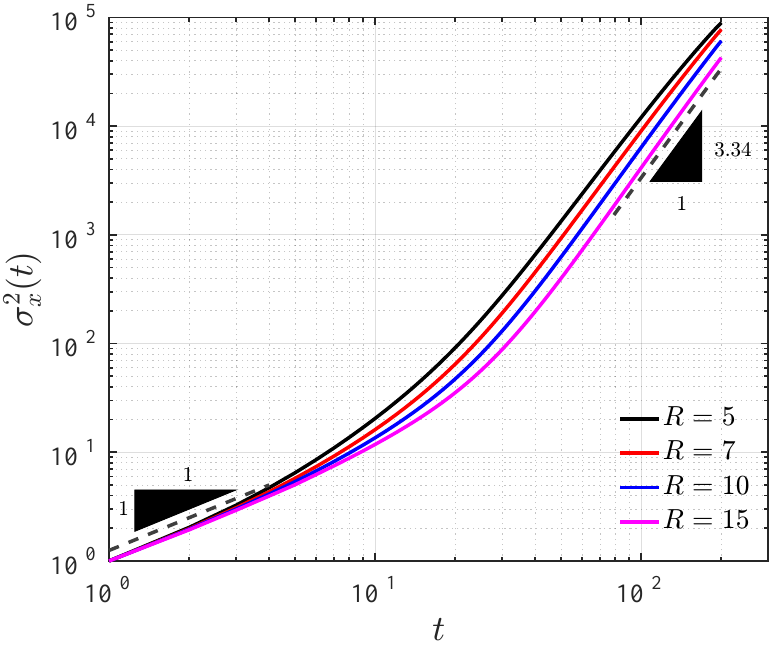
Figure 6. Temporal evolution of axial variance σ 2 x ( t ) for viscosity ratio in the range O ( 10 2 ) – O ( 10 6 )